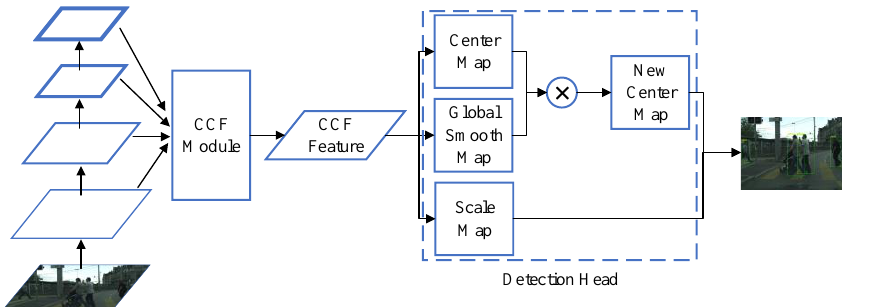
Figure 1. The overall structure of Cascaded Cross-layer Fusion Network (CCFNet). It includes two parts: CCF module and detection head. CCF cascades and reuses features to generate low-level feature maps with contextual semantic information. This feature map generates center map, scale map, and global smooth map through the detection head. And generate the new center map with global information by integrating center map and global smooth map. Finally, locate and mark the